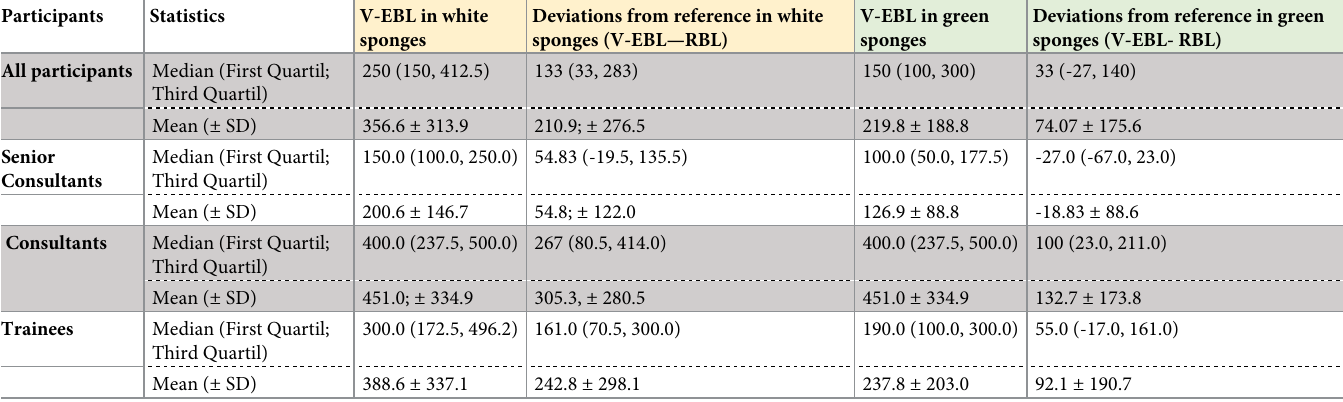
Table 1. Results of visually blood loss estimation in white and green